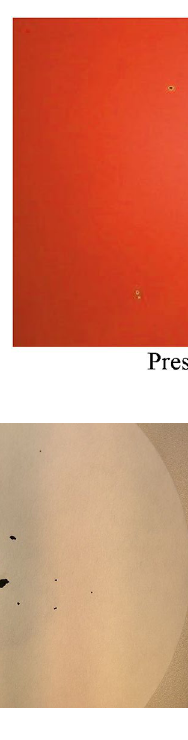
Fig. 6 Asphaltene sample after pumping of oil through organic solid filter